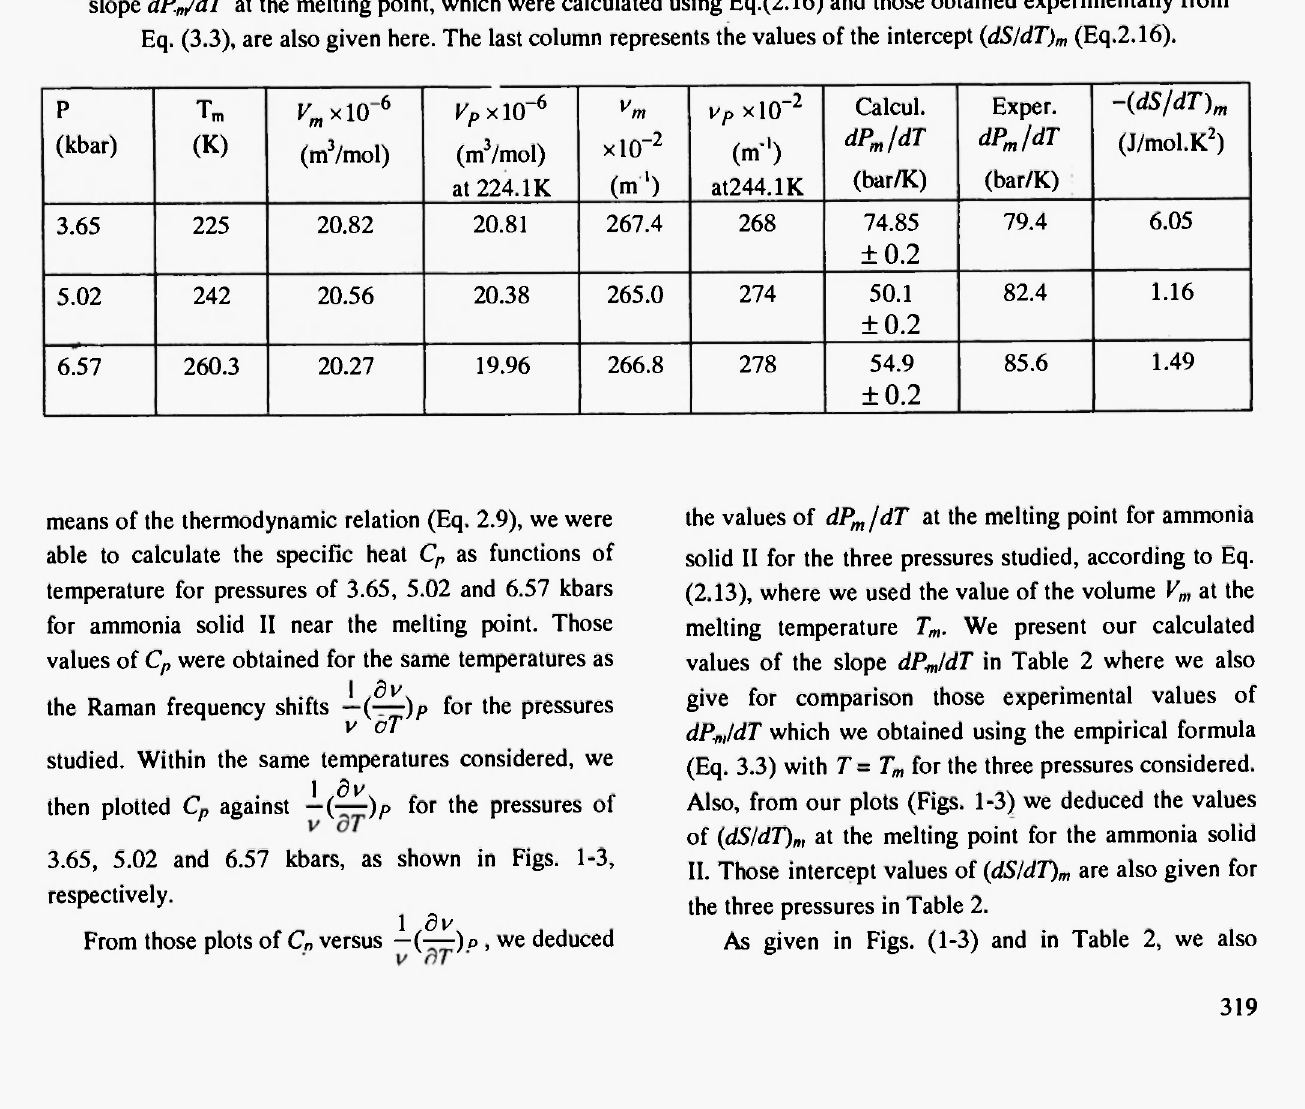
Values of the molar volume and the Raman frequency of the rotatory lattice (librational) mode at the melting temperature T m and at Τ = 224.1 Κ in the ammonia solid II for the pressures indicated (see Ref. 19). The values of the slope dP„/dT at the melting point, which were calculated using Eq.(2.16) and those obtained experimentally from Eq. (3.3), are also given here. The last column represents the values of the intercept ( dS/dT) m